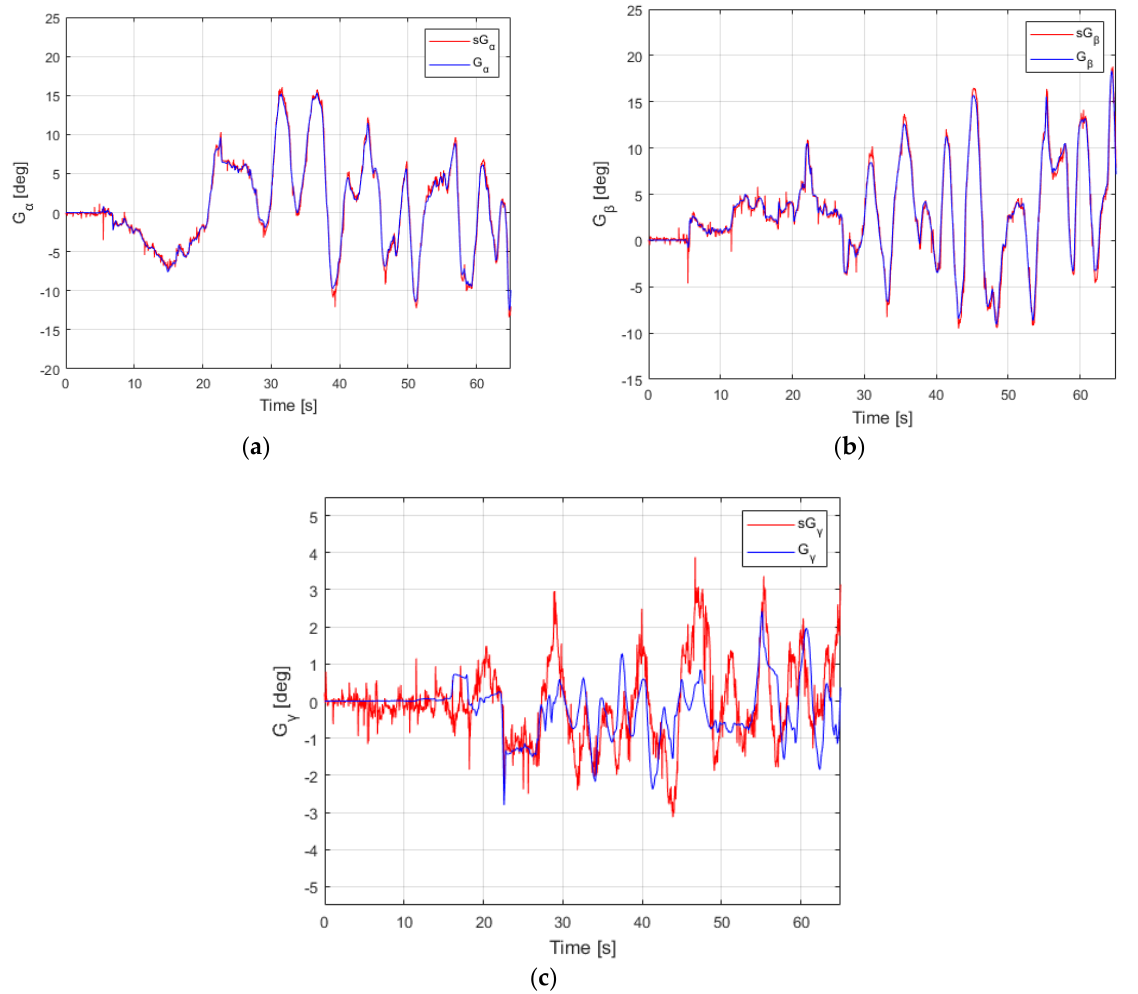
Figure 13. Experimental results—orientation of the end effector ( a ) parameter G α ( b ) parameter G β ( c ) parameter G γ .